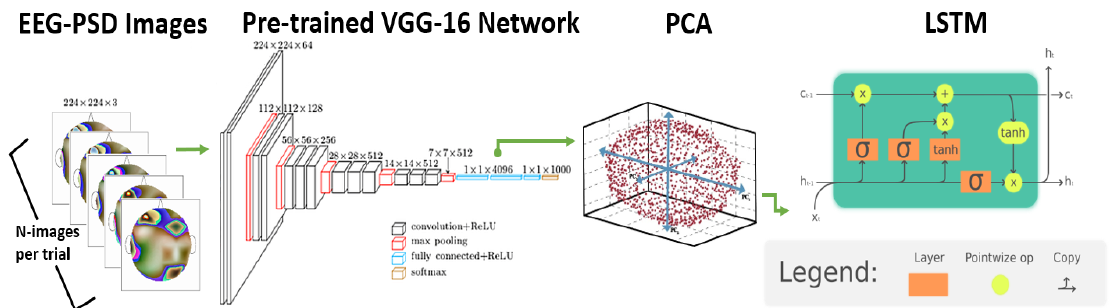
Figure 4. Network architecture for EEG-PSD trend-based Deep Learning